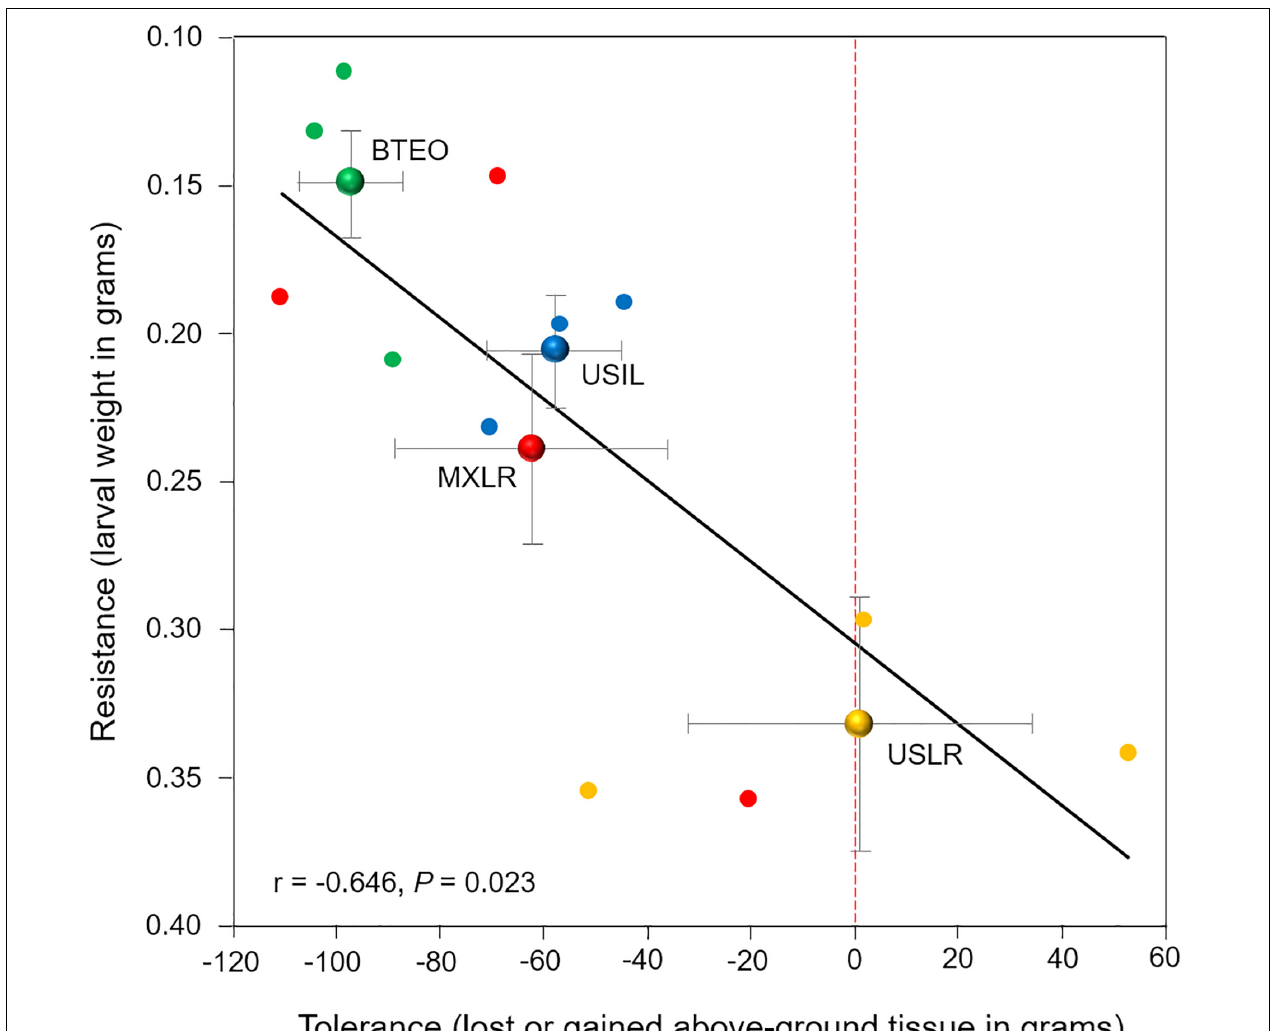
FIGURE 7 | Relationship between resistance (expressed as larval weight) and tolerance (expressed as plant tissue loss or gain) to root herbivory by Western corn rootworm larvae in 12 plant accessions (small circles), with three accessions corresponding to each of four plant types (large circles with bi-directional standard error bars). (Note that Y -axis values increase from top to bottom). Plant types are Balsas teosintes (BTEO), Mexican maize landraces (MXLR), US maize landraces (USLR), and US inbred maize lines (USIL). The weight of Western rootworm larvae (g) after 10 days of feeding on each accession was used as a proxy for resistance, while the loss or gain of above-ground tissue (g) of each accession after 10 days of exposure to root herbivory by rootworm larvae was used as a proxy for tolerance. Inset is Pearson’s correlation r statistic corresponding to the 12 plant accessions. The red, dotted vertical line on x -axis indicates tissue compensation (i.e., no tissue lost nor gained); means to the left of the dotted line are suggestive of undercompensation for tissue loss, and means to the right are suggestive of overcompensation for tissue loss.